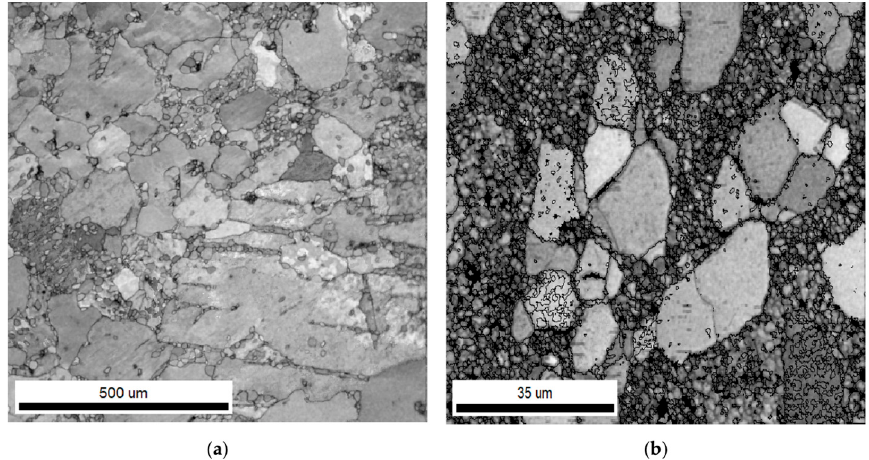
Figure 1. Optical microscopy of the cross-section of as-extruded: ( a ) pure Zn; ( b ) Zn-1.89Mg. Note the different scale bars.